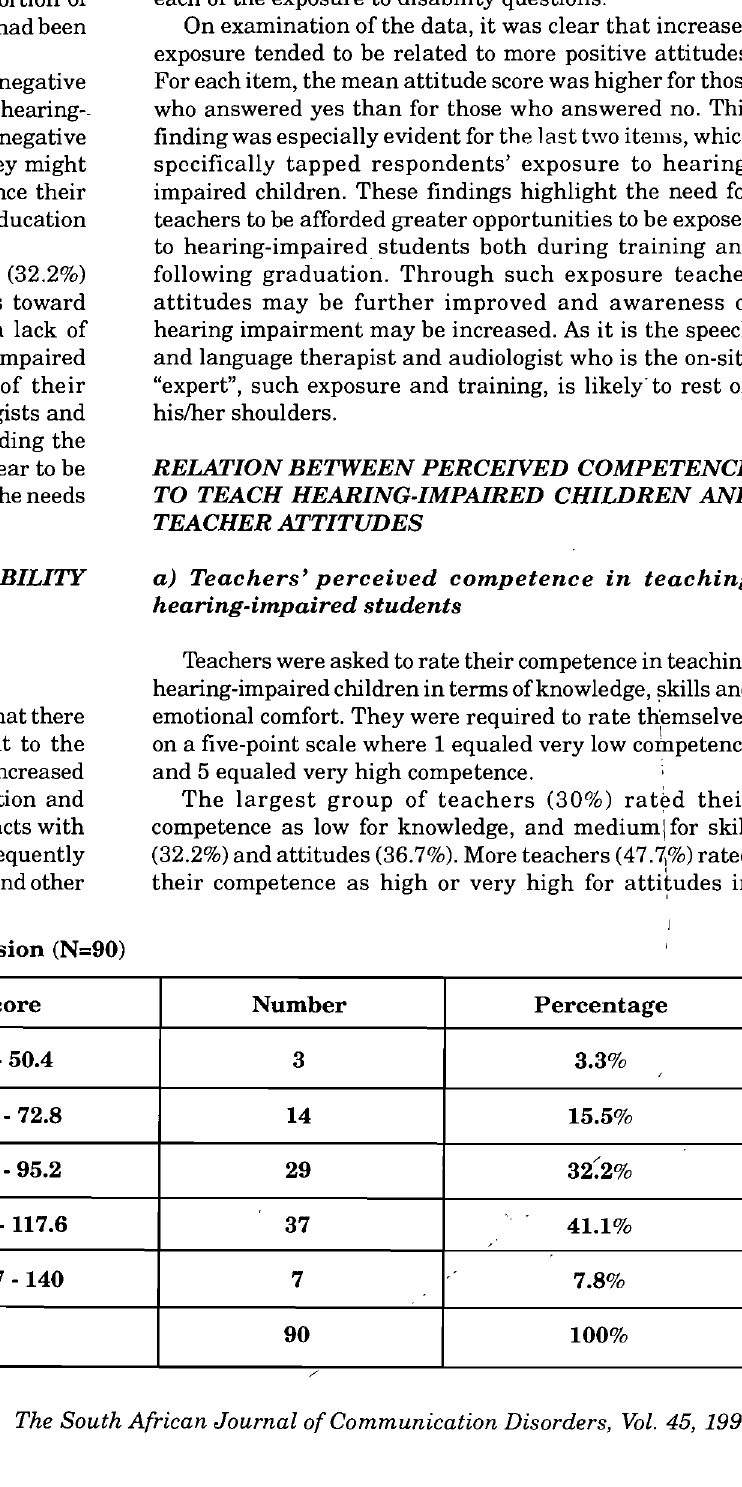
TABLE 2: Teachers' Attitudes Towards Inclusion (N=90)